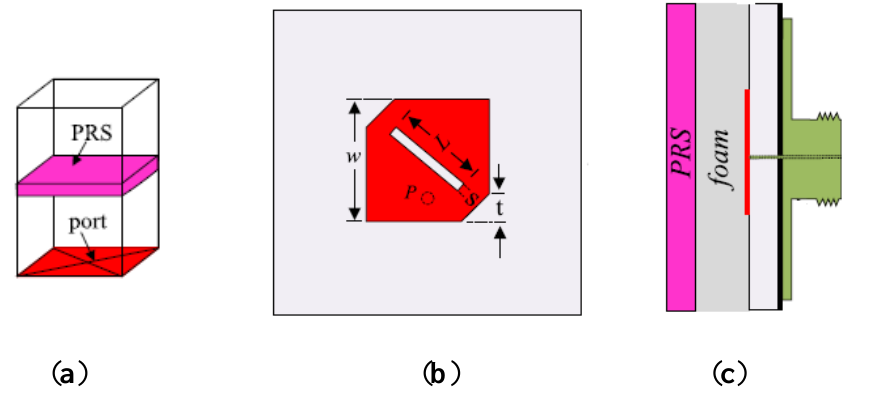
Figure 12. Configuration of a CP RCA: ( a ) Unit cell; ( b ) Main radiator; ( c ) Entire RCA structure [42].